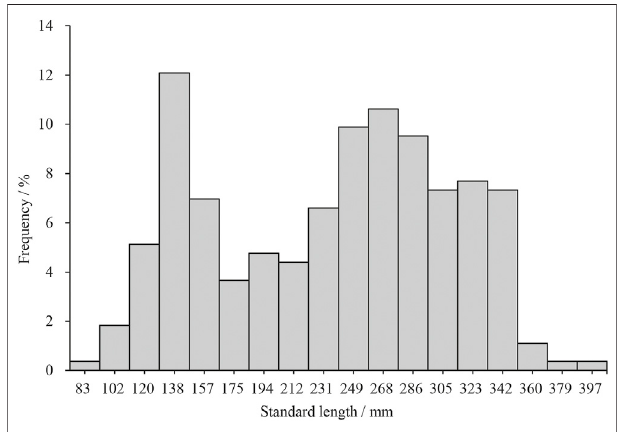
FIGURE 2 | Frequency distribution of Acanthopagrus schlegelii body length from Zhanjiang estuary waters, northern South China Sea.